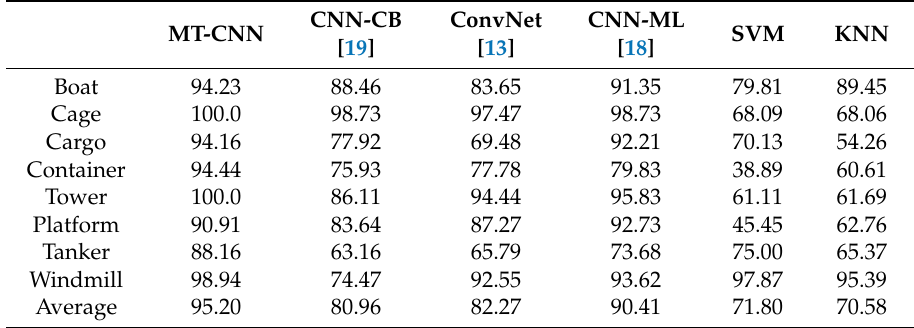
Table 5. Classification accuracies (%) of different existing